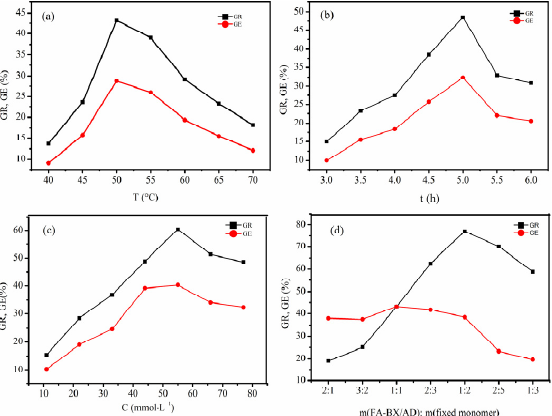
Figure 1. ( a ) Influence of reaction temperature on GR and GE . ( b ) Influence of reaction time on GR and GE . ( c ) Influence of initiator concentration on GR and GE . ( d ) Influence of the mass ratio of FA-BX/AD to mixed monomers on GR and GE .